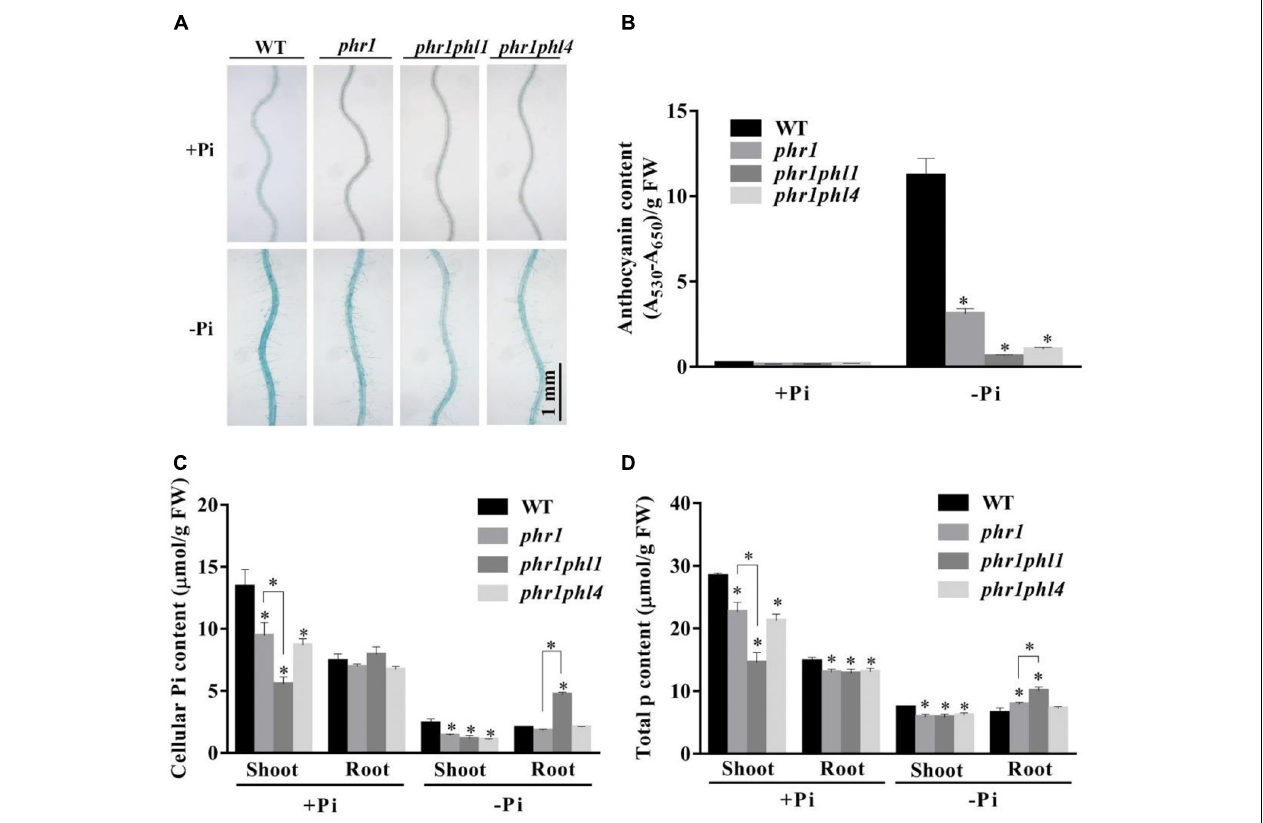
FIGURE 7 | Analyses of root-associated APase activity, anthocyanin, cellular Pi, and total P contents of the WT, phr1 , phr1phl1 , and phr1phl4 on +Pi and –Pi media. (A) The APase activities revealed by BCIP staining on the root surfaces of 6-day-old seedlings of the WT and various mutants. (B) Anthocyanins in the shoots of 12-day-old seedlings of the WT and various mutants. (C,D) Cellular Pi and total P contents in the shoots and roots of 12-day-old seedlings of the WT and various mutants. These experiments were repeated three times with similar results. Values represent means ± SD of three replicates. Means with asterisks are significantly different from the WT ( P < 0.05, t -test). Means with asterisks and thin lines are significant different from each other ( P < 0.05, t